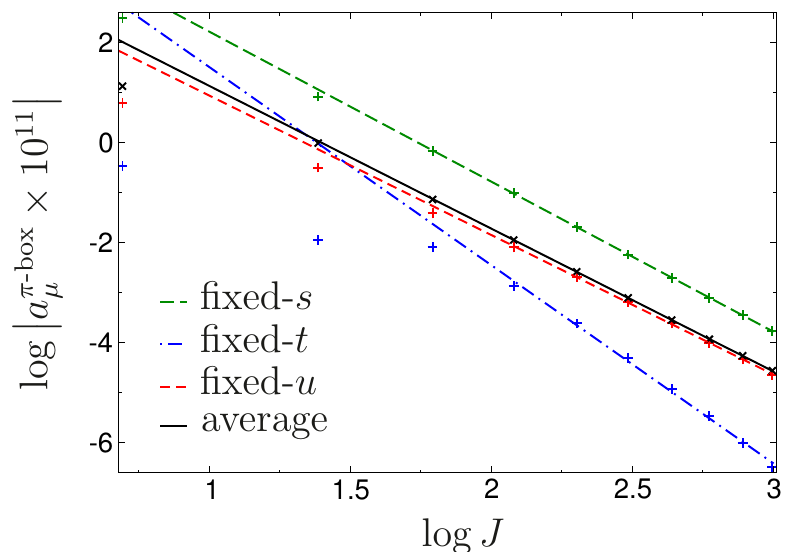
Figure 12. Extrapolation of the partial-wave results for the (cid:12)xed-( s; t; u ) representations as well as their average, see main text for